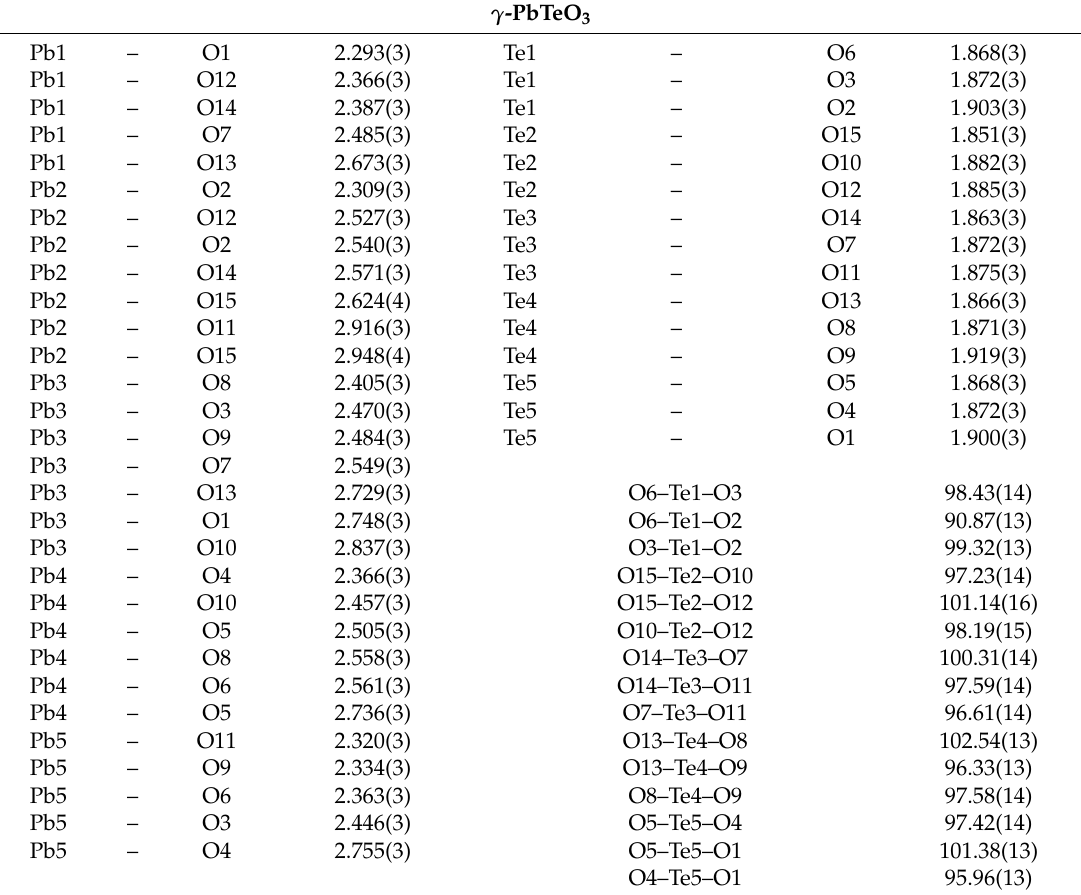
Table 2. Selected interatomic distances/Å and angles/ ◦ , as well as results from BVS calculations/v.u. (1) . γ -PbTeO